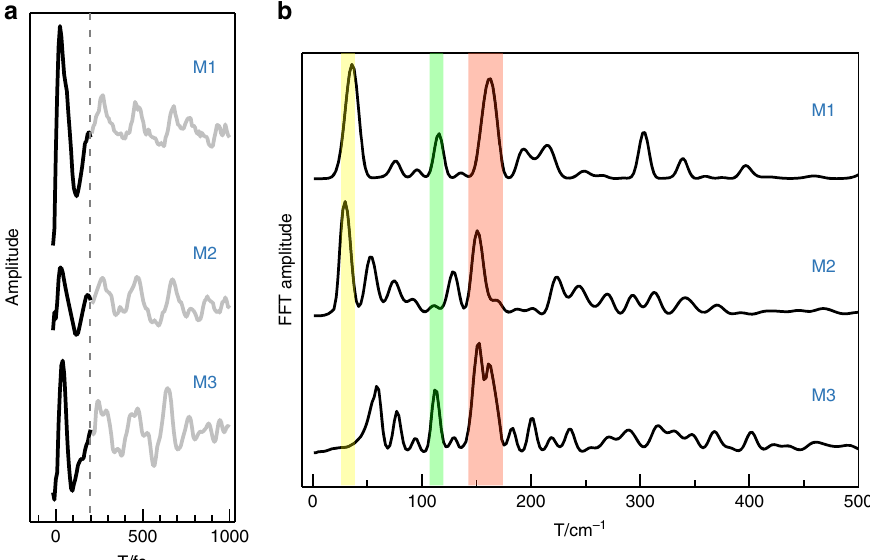
Fig. 4 Quantum beats and Fourier transform (FT) power spectra. The top, middle, and bottom traces represent M1 , M2 , and M3 . a Real-part T traces at the cross-peak locations as labeled with a cross in Fig. 3 after subtraction of multiexponential dynamics. b Summary FT power spectra of the oscillations in the real-part signals (0 – 2